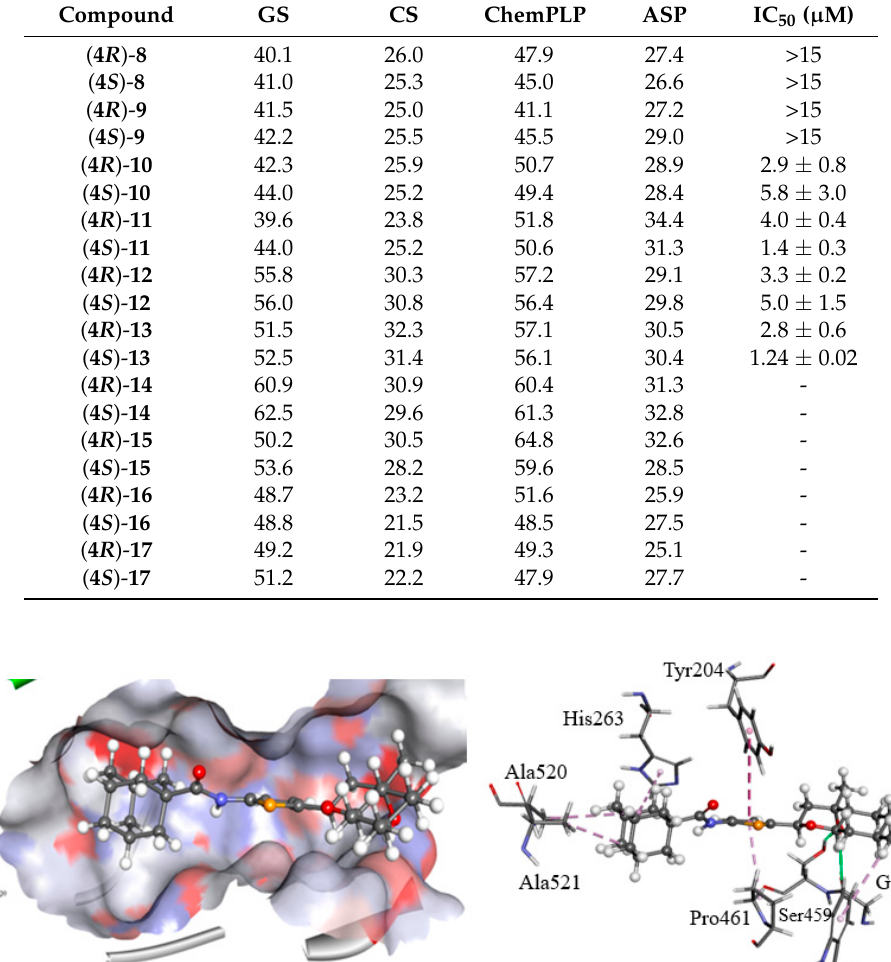
Table 2. Results of the Scoring Functions (GS, CS, ChemPLP, and ASP) for Compounds 8–17 with Tdp1. The IC 50 Values of Compounds 8–13 with Tdp1 were Also Included.